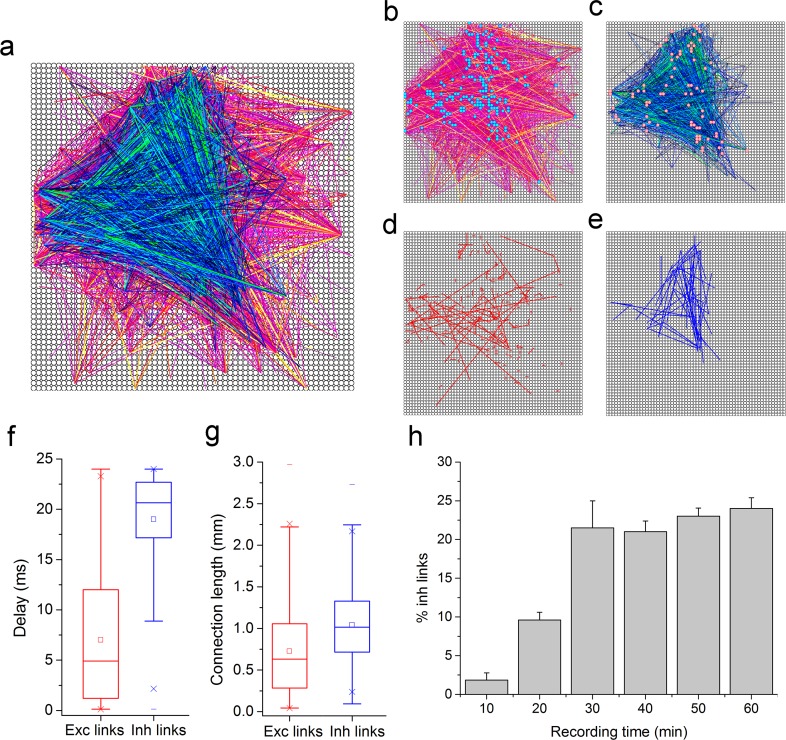
Functional connectivity analysis on cortex neural networks populations coupled to the MEA-4k.a, Functional connectivity graph obtained by applying the FNCCH to a cortical network at DIV 21 coupled to a MEA-4k device. Excitatory and inhibitory links are separately thresholded and shown, for reader convenience, in panel b, (excitation, red color map) and c, (inhibition, blue color map). Color scales are indicative of the relative connection strength based on the peak of FNCCH. Cyan circles in panel b and pink circles in panel c represent the identified rich club sub-networks. Functional connectivity maps showing the d. 200 excitatory and e. 50 inhibitory strongest links. f, Box plot of statistical distribution of the delays of the detected functional links. g, Box plot of the statistical distribution of the connection lengths of the detected links. h, Percentage of the inhibitory links revealed by the FNCCH at varying the recording time.